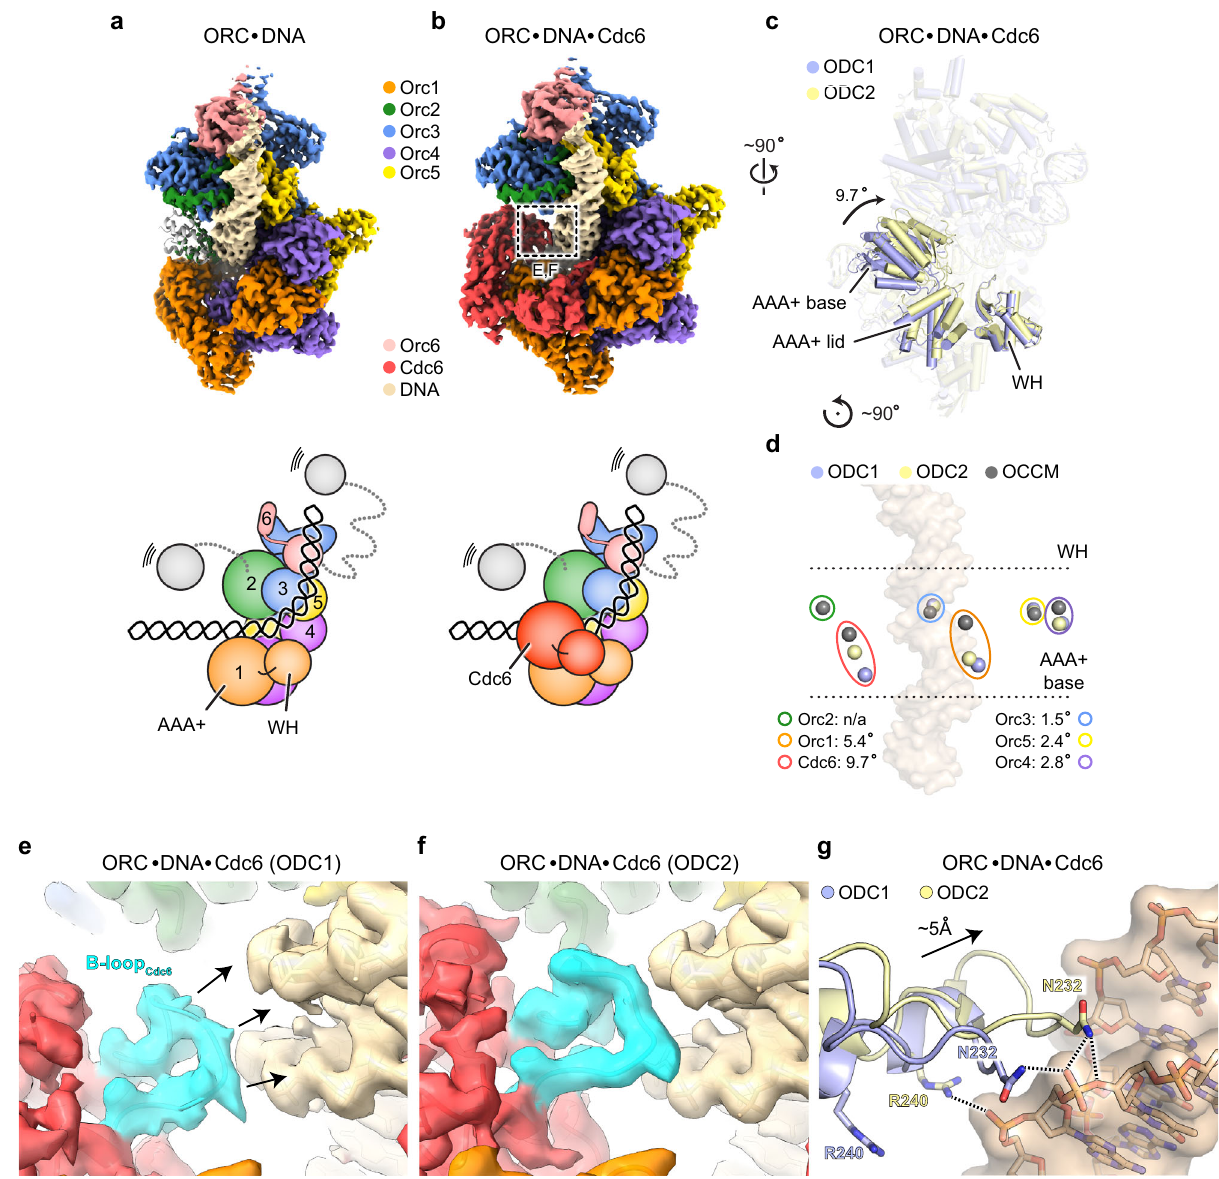
Fig. 1 Conformational changes in the Sc ORC·Cdc6 ring alter Cdc6 ’ s DNA binding mode. Cryo-EM structures of ARS1 DNA-bound Sc ORC (in a ) and in complex with Sc Cdc6 (ODC1, in b ). Unsharpened cryo-EM maps are shown surface-colored by subunit with schematics below. In a , the Orc2 WH domain of an Sc ORC·DNA structure obtained from crosslinked sample (PDB 5zr1 6 ) is shown as gray cartoon. Weak density in the current Sc ORC·DNA cryo-EM map indicates fl exibility of this region in the uncrosslinked complex. Zoomed views of boxed region (in b ) are provided in panels e and f . c Cdc6 is found in two different positions in the ORC·Cdc6 ring, which are related by a ~10° rotation of the subunit. Both Sc ORC·DNA·Cdc6 structures (ODC1 in blue and ODC2 in yellow) were aligned by superposing Orc2. Cdc6 is shown as solid cartoon while other subunits are transparent (WH – winged-helix domain). d Repositioning of Cdc6 is caused by movement of both Orc1 and Cdc6 in the ORC·Cdc6 ring. Centers of mass of the AAA + base domains of Orc1-5 and Cdc6 in ODC1, ODC2, and OCCM (PDB 5v8f 8 ) are shown as blue, yellow, and gray spheres, respectively. Corresponding subunits are outlined using colors as in ( a ). Angular displacements of corresponding subunits between ODC1 and ODC2 are listed. e – g Cdc6 repositioning facilitates novel contacts between the Cdc6-B-loop and DNA. Unsharpened cryo-EM map densities of DNA and the Cdc6 B-loops (highlighted in cyan) of ODC1 (in e ) and ODC2 (in f ) are shown. In g , the Cdc6 B-loop regions of ODC1 and ODC2 are superposed after structural alignment of the DNA duplexes. Electrostatic interactions are indicated by dashed lines. The color schemes used in this fi gure are maintained throughout the manuscript unless noted